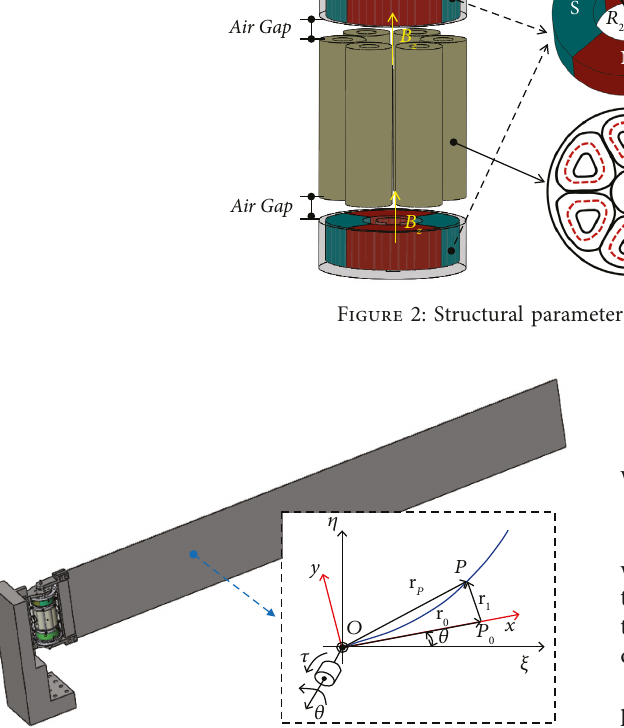
Figure 3: Configuration of a large flexible rectangular